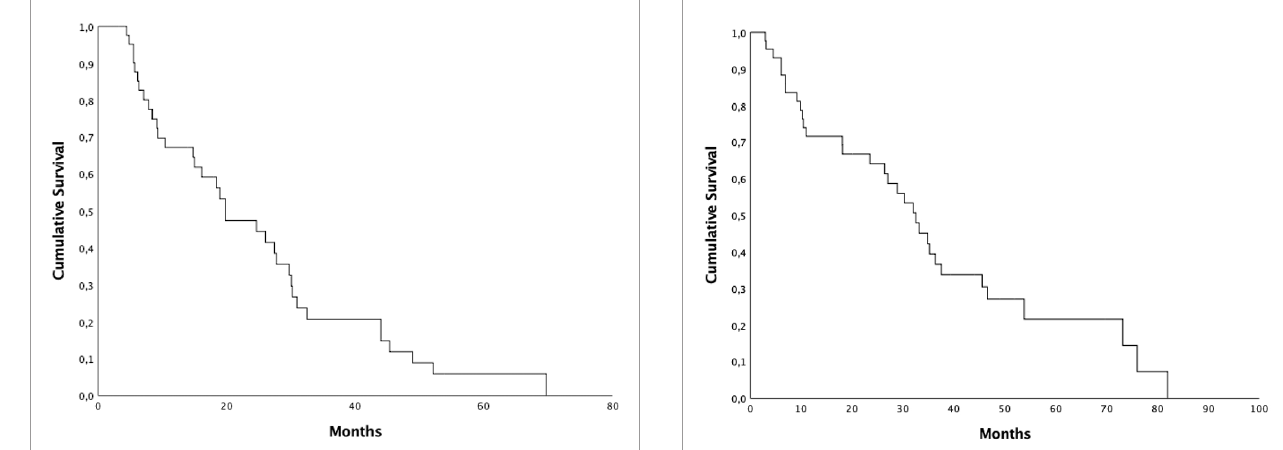
FIGURE 1 | Kaplan-Meyer progression-free survival curve. FIGURE 2 | Kaplan-Meyer overall survival